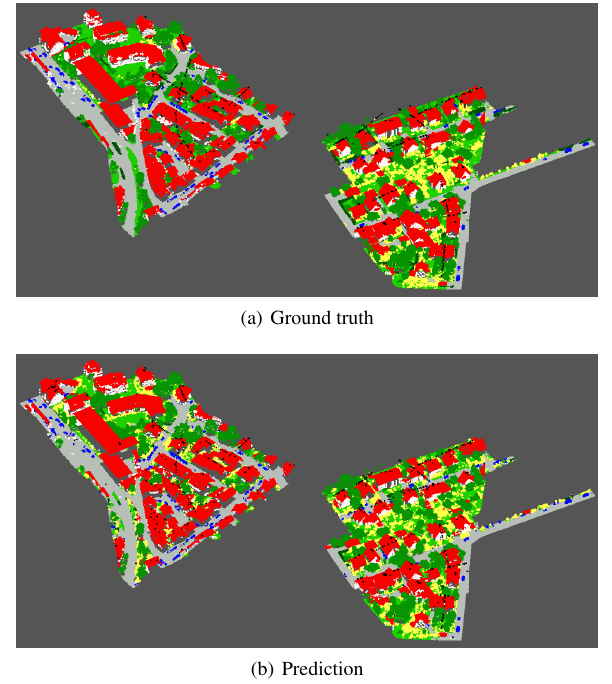
Figure 6. V3D test set. Color coding roughly following (Blom- ley and Weinmann, 2017). Black: Powerline; light green: Low vegetation; gray: Impervious surface; blue: Car; dark green: Fence/Hedge; red: Roof; white: Facade; yellow: Shrub; medium green: Tree.